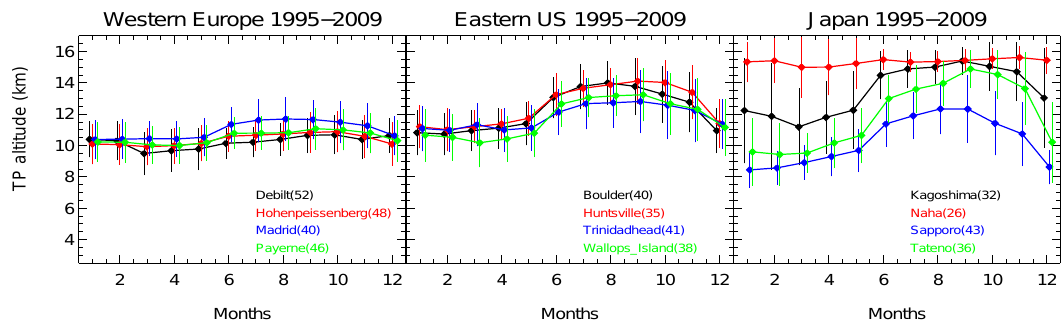
Fig. 11. Seasonal evolution of the location of the thermal tropopause for selected stations in Western Europe, US and Japan, averaged between 1995 and 2011. The standard deviation is shown as error bars. The latitude location of the selected stations is shown in brackets behind the station